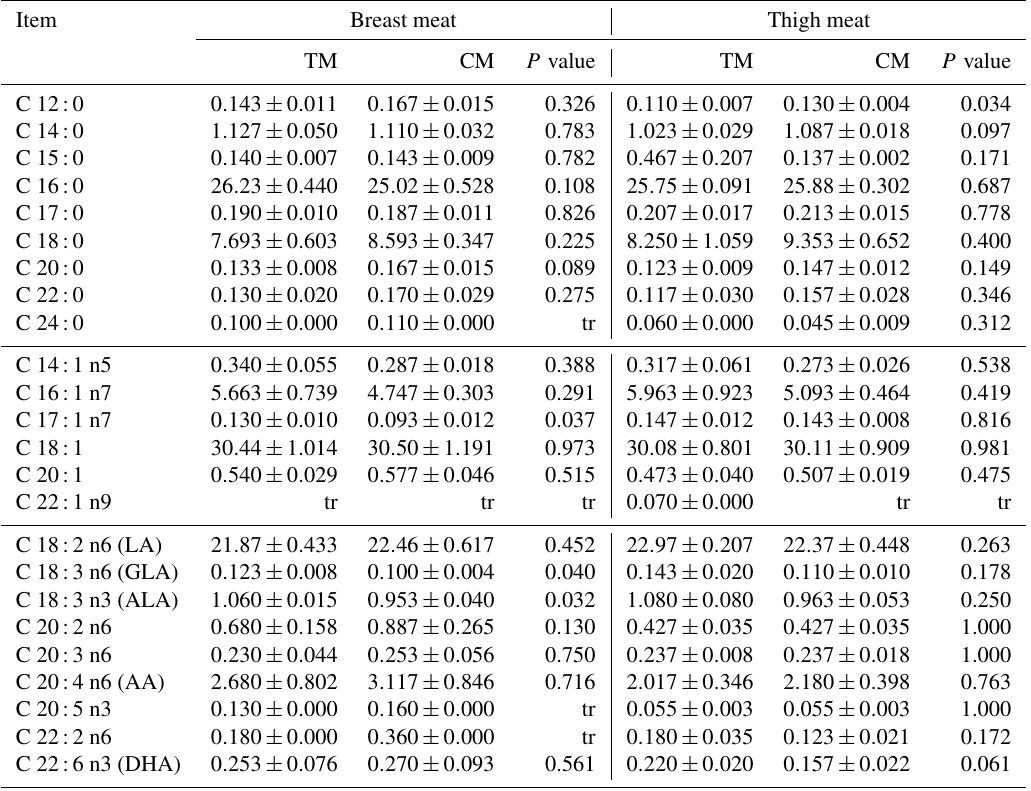
Table 5. The content of particular fatty acids in breast and thigh meat of guinea fowl in response to diets based on nutrient specifications for three- or two-phased diets (mean ±